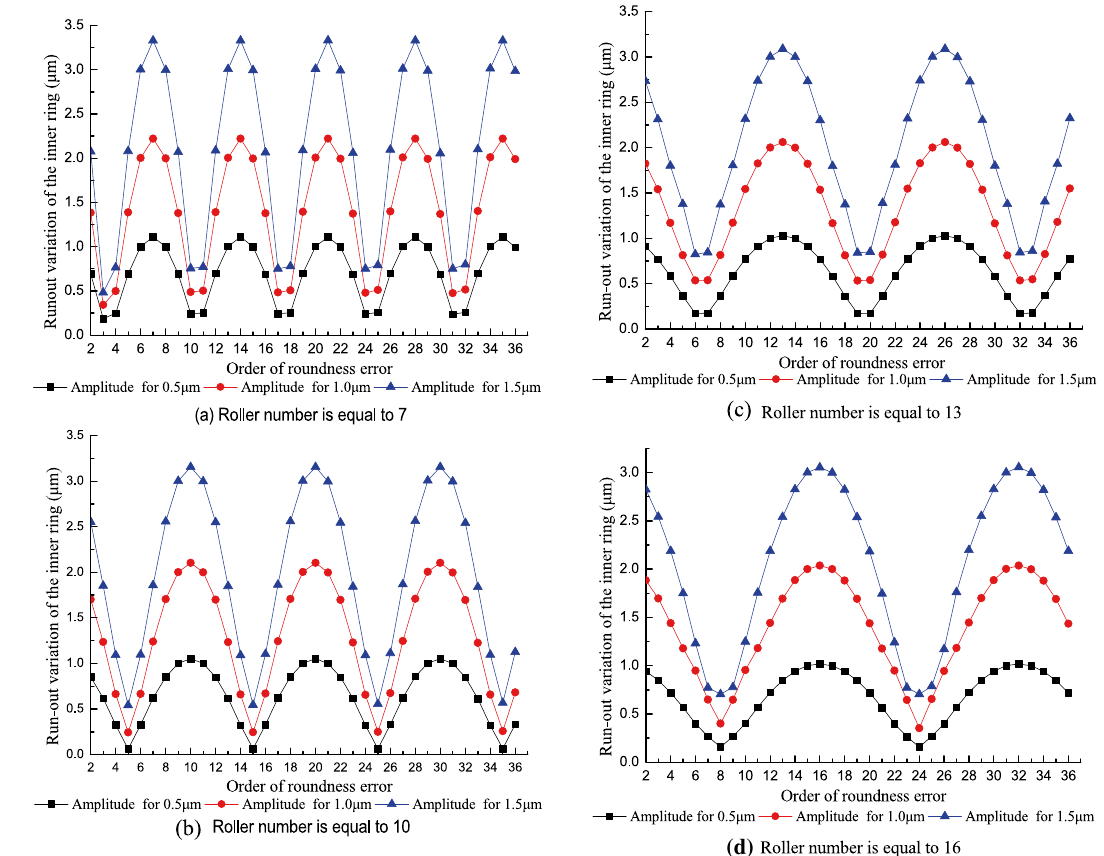
Figure 9. Effect of the order of the roundness error in the inner raceway on the run-out variation of the inner error. When the order of roundness error is less than half of the roller number, and the order of roundness error is equal to 2 or 4 the amplitude of roundness error has less influence on the run-out variation of the inner ring. When the order of roundness error is more than half of the roller number and is equal to (2 n − 1) Z /2 (where n is a natural number and Z is an even number) or to ( Z ± 1)/2 + (2 n − 1) Z (where Z is an odd number) the amplitude of roundness error in the outer raceway has less influence on the run-out variation of the inner ring. When the order of roundness error is equal to nZ the amplitude of roundness error in the outer raceway has a significant effect on the run-out variation of the inner ring.